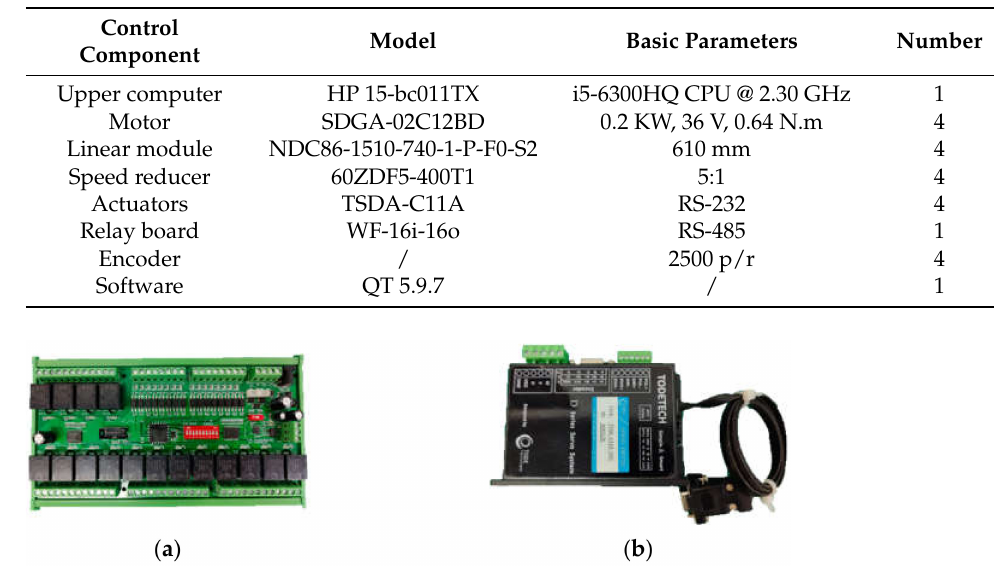
Figure 11. Control assembly. ( a ) Relay board. ( b ) TSDA-C11A